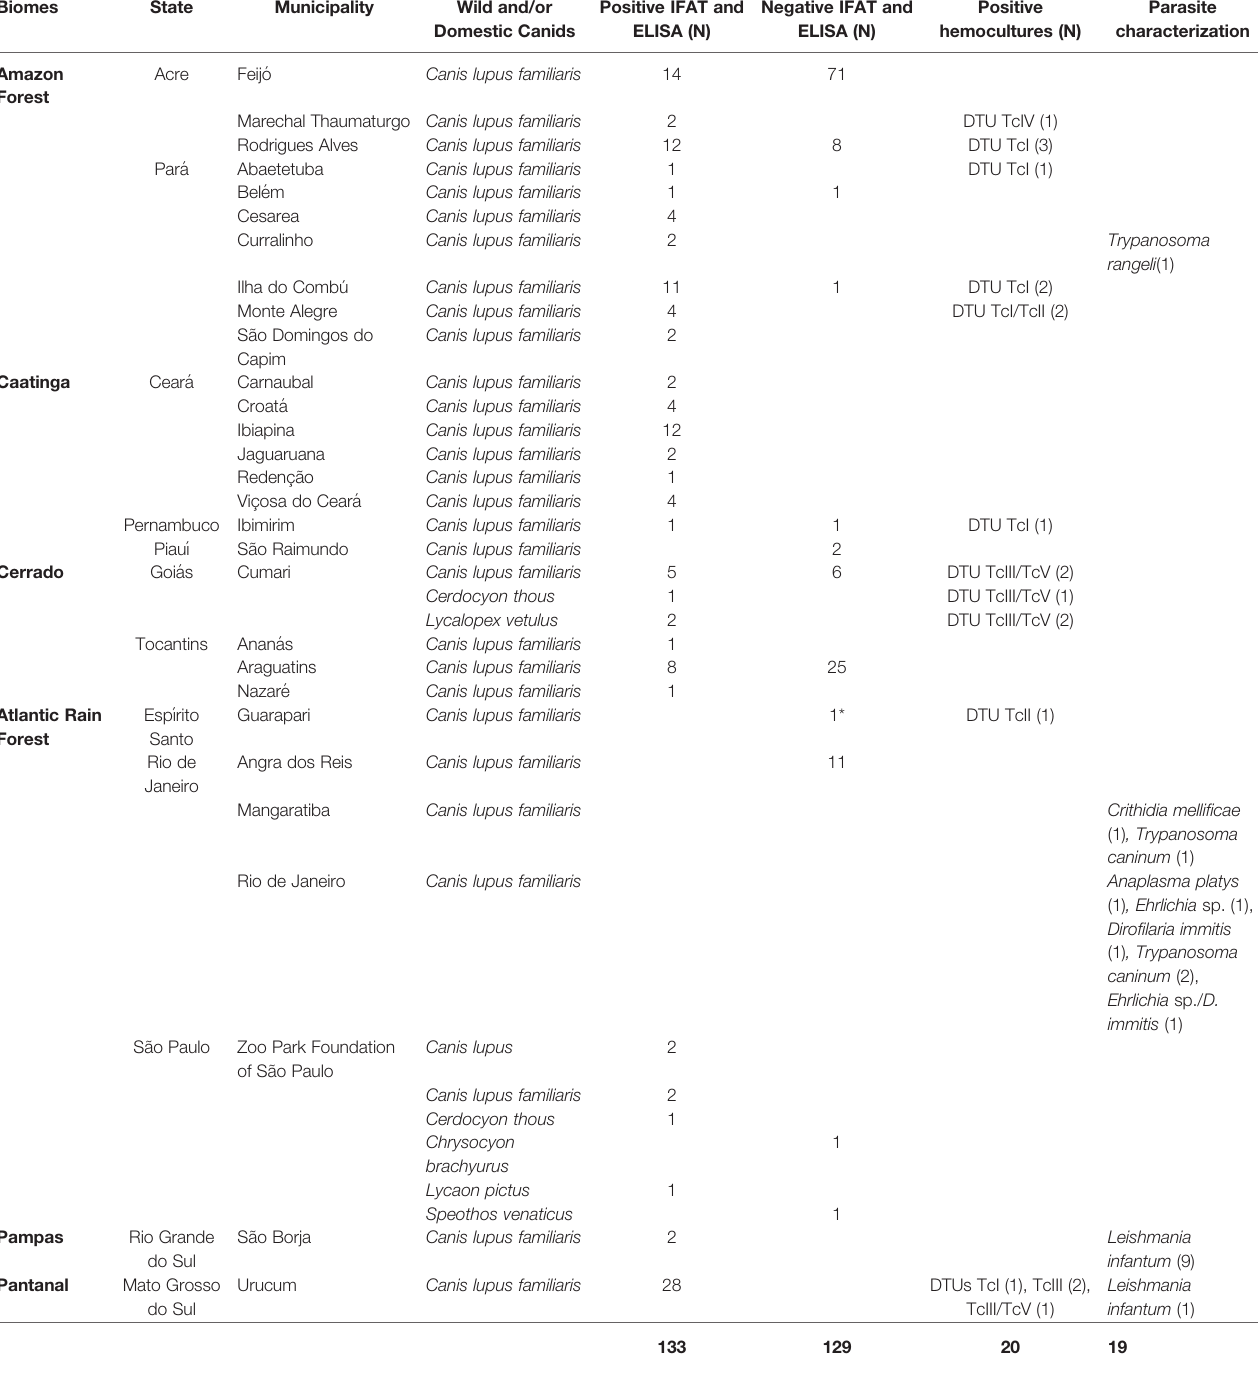
TABLE 1 | Distribution of wild and domestic canids in the Brazilian biomes based on molecular characterization of parasite populations isolated in blood cultures, the total number examined by blood cultures and serological tests.